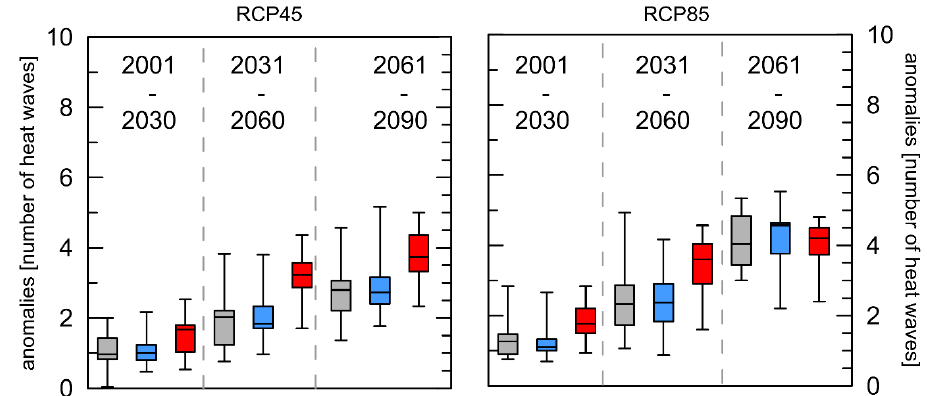
Figure 3. Boxplots of mean anomalies of the number of heat waves per year (HW-N) with reference to the 30-year period 1971–2000 for the three cities London (grey), Luxembourg (blue), and Rome (red) and two different RCPs. Whiskers = 5/95 percentile.